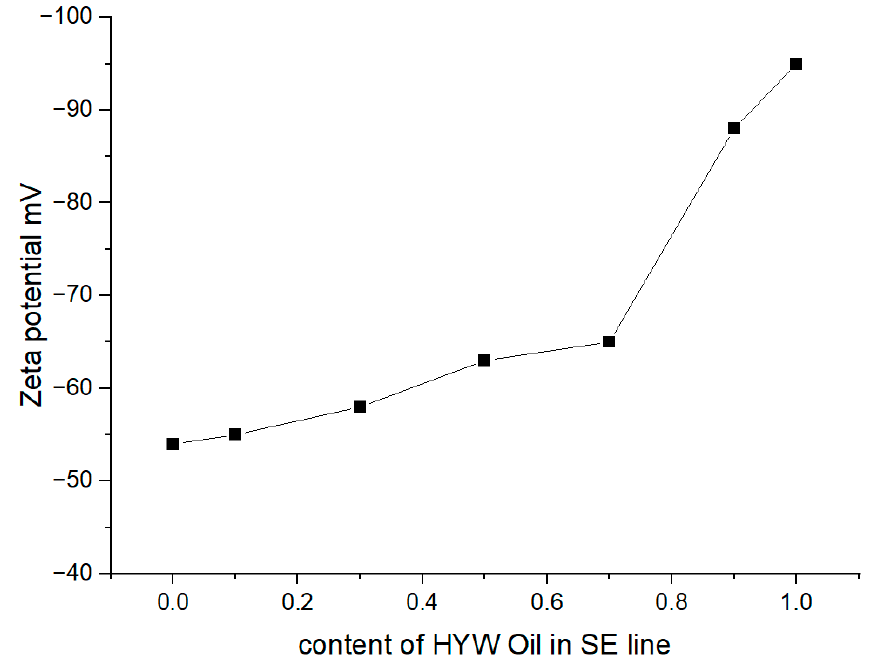
Figure 6. Effect of HYW and SE Blended Ratio on Zeta Potential.